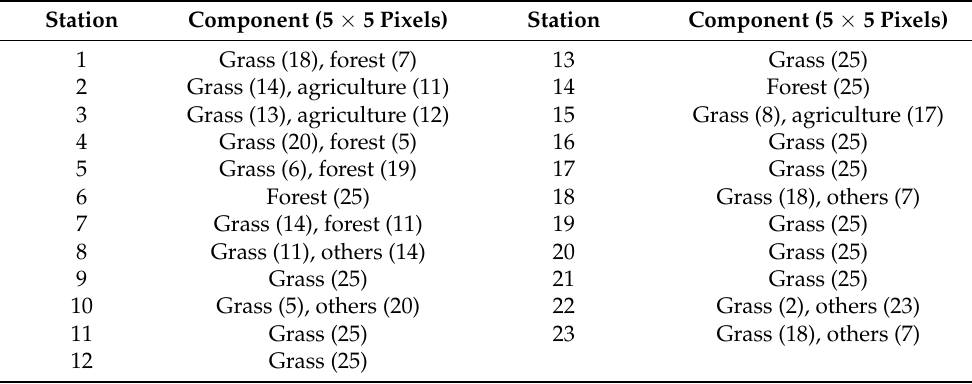
Table 1. The land use/land cover of 5 × 5 pixels corresponding to each